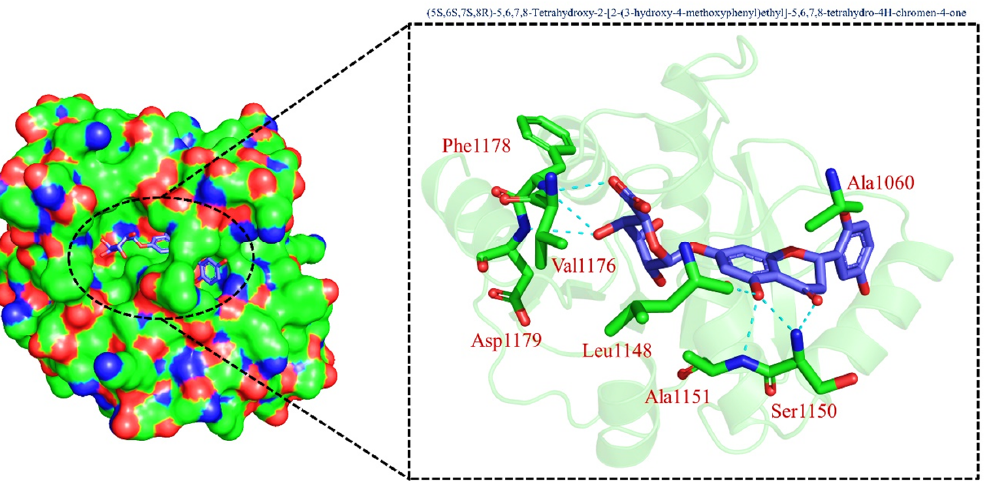
Figure 4. Binding of TCM30675 or (5S,6S,7S,8R)-5,6,7,8-Tetrahydroxy-2-[2-(3-hydroxy-4-methoxyphenyl)ethyl]-5,6,7,8-tetrahydro-4H-chromen-4-1 in the cavity of Mac-I. The right surface representation shows the binding mode of TCM30675 or (5S,6S,7S,8R)-5,6,7,8-Tetrahydroxy-2-[2-(3-hydroxy-4-methoxyphenyl)ethyl]-5,6,7,8-tetrahydro-4H-chromen-4-1 (blue sticks) inside the binding cavity. The right panel represent the 3D interaction pattern, where the TCM30675 or (5S,6S,7S,8R)-5,6,7,8-Tetrahydroxy-2-[2-(3-hydroxy-4-methoxyphenyl)ethyl]-5,6,7,8-tetrahydro-4H-chromen-4-1 is shown as orange sticks, while the interacting residues are given in green sticks. The interactions (hydrogen bonds) are shown in blue color.